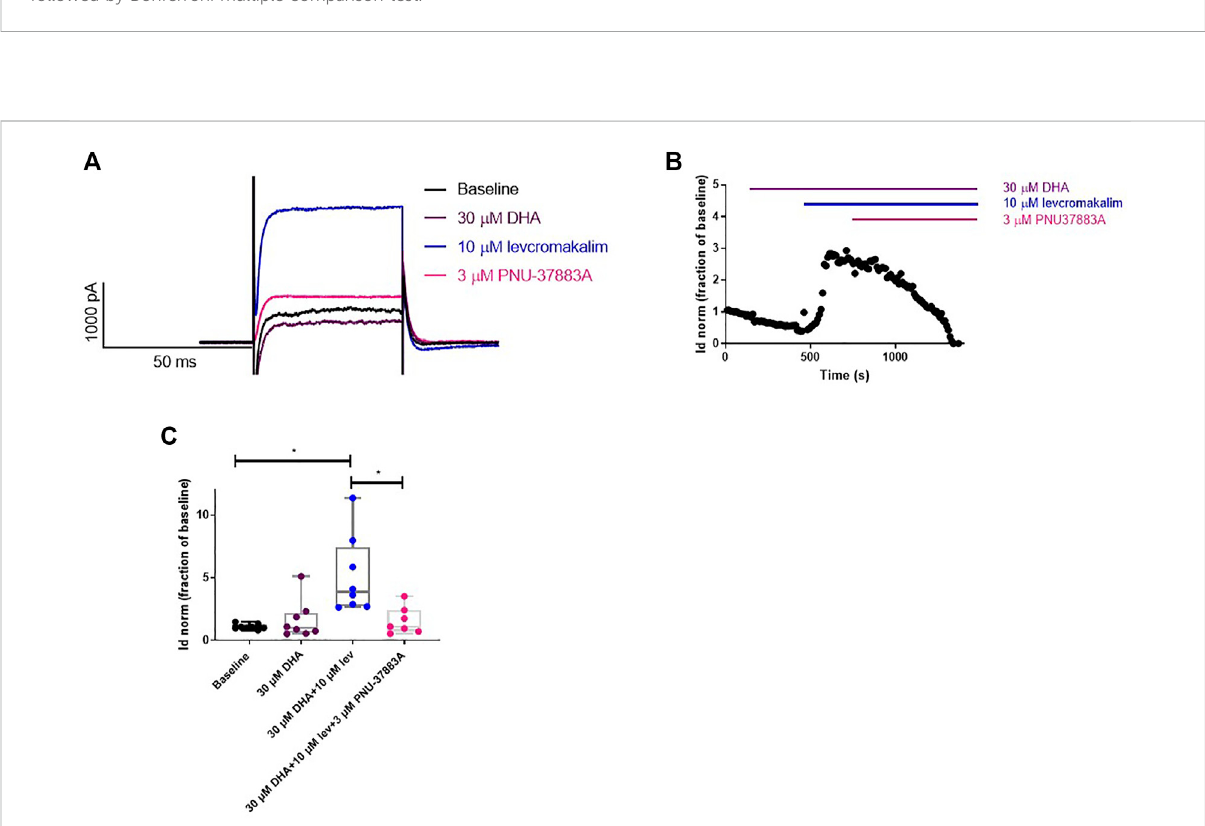
FIGURE 5 DHA does not affect K + currents in vascular smooth muscle cells isolated from mouse aorta. (A) Representative current traces. (B) Representative whole cell current density time course trace. (C) DHA (30 µm) does not affect the K + current density in primary mouse aorta VSMCs. The K ATP -selective opener levcromakalim (10 µm) causes an increase in these currents which is reversed by the K ATP blocker PNU-37883A (3 µm). n = 8, data represented as normalised current density as a fraction of the baseline, with median and min to max whiskers. * p < 0.05, signi fi cant difference from baseline curve assessed by one-way ANOVA with Friedman ’ s test and Dunn ’ s correction for multiple comparisons. Lev = levcromakalim.